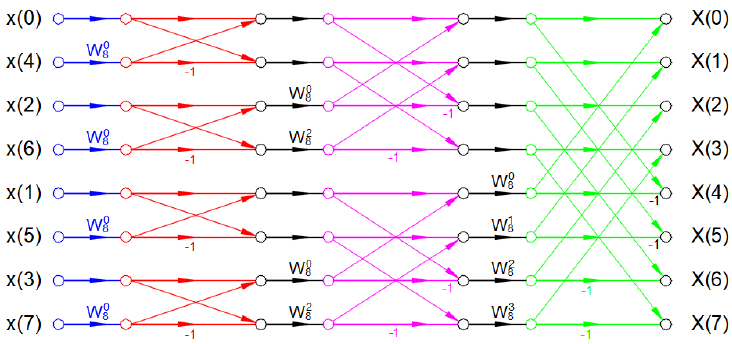
Figure 4. Eight-point radix-2 decimation-in-time FFT [15].